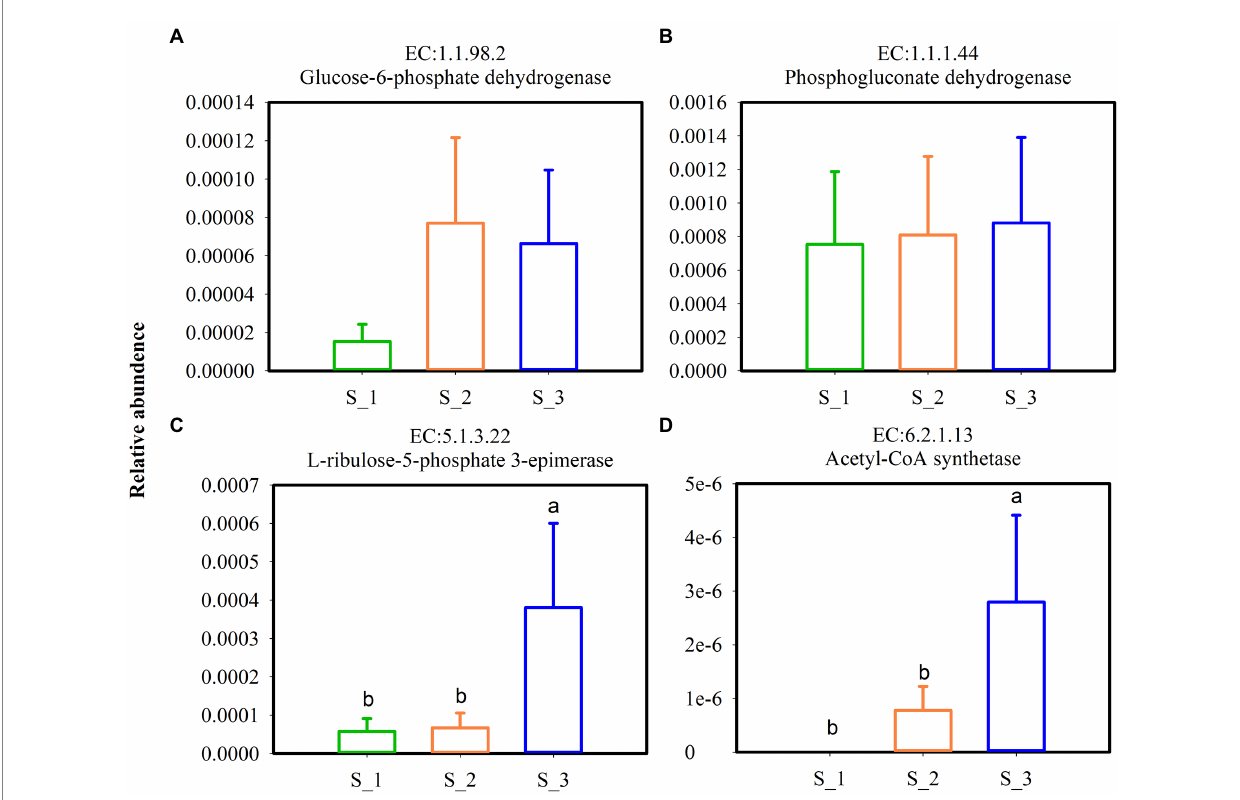
FIGURE 10 Key enzymes involved in pentose phosphate pathway (A–C) and acetyl-CoA synthetase (D) in the three cutting alfalfa silage. S_1, ensiled alfalfa in the first cutting, S_2, ensiled alfalfa in the second cutting, S_3, ensiled alfalfa in the third cutting. The green non-filled bar indicate S_1, the orange non- filled bar indicate S_2, the blue non-filled bar indicate S_3. EC, reference metabolic pathway highlighting numbers; means within the same column with different letters differ significantly from each other ( p <